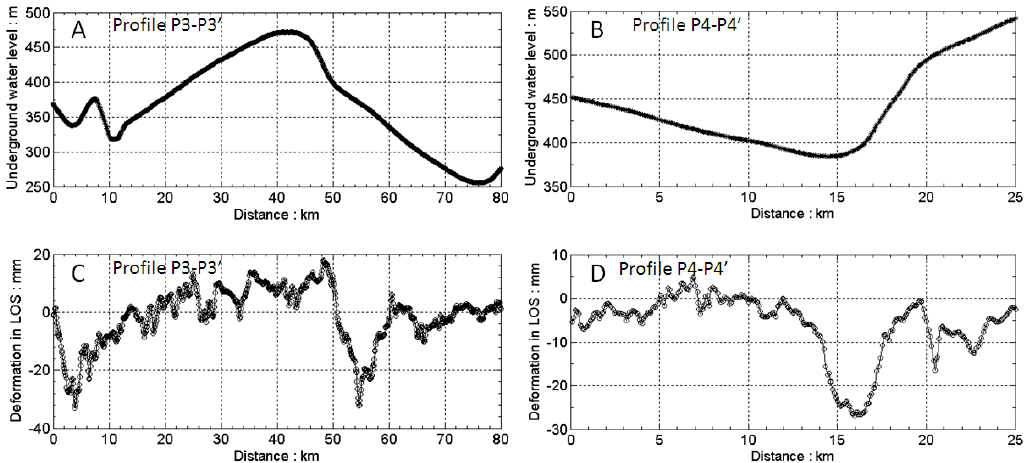
Figure 8. Profiles of groundwater level and ground deformation: ( A , B ) groundwater level profiles along P3–P3’ and P4–P4’ (Figure 7); and ( C , D ) respective deformation profiles along the same